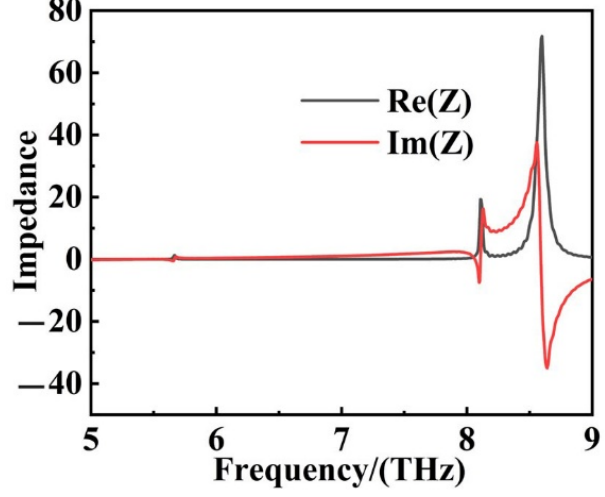
Figure 4. The real part Re(Z) and the imaginary part Im(Z) of the effective impedance Z of the ultra-narrow SPR absorber.